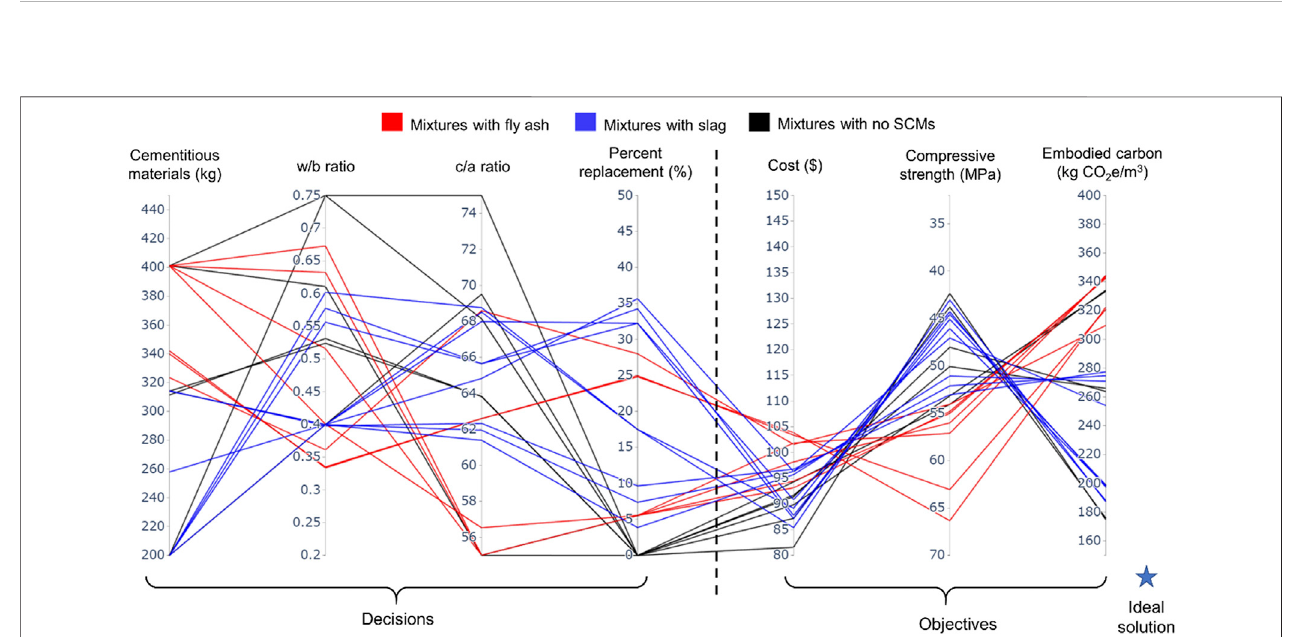
FIGURE 4 | Set of optimal mixture designs for San Francisco case